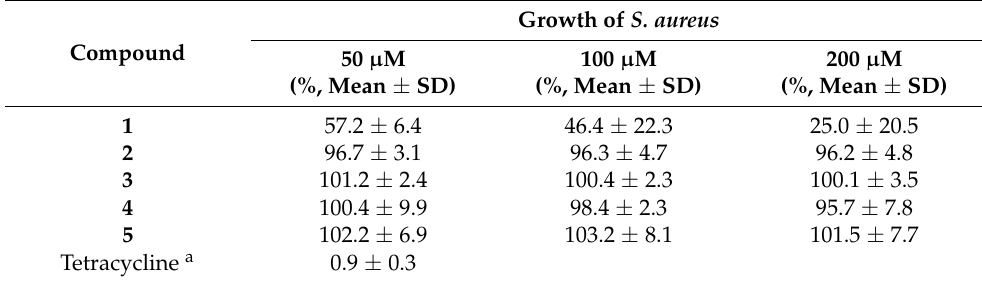
Table 3. Inhibitory effects of compounds 1 – 5 on the growth of S. aureus .